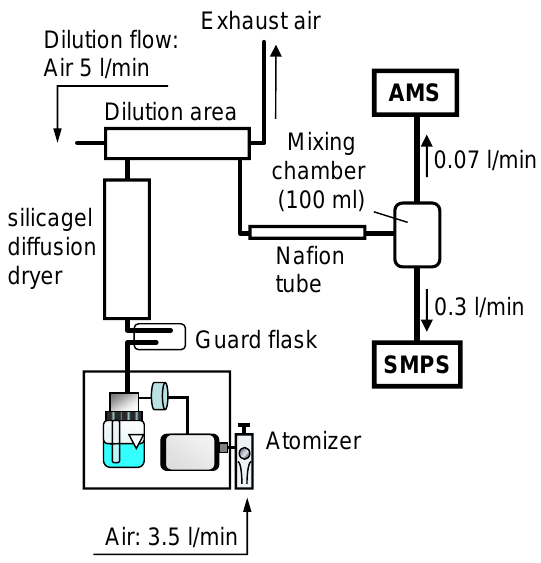
Figure 1. Schematic overview of the aerosol generation set-up.